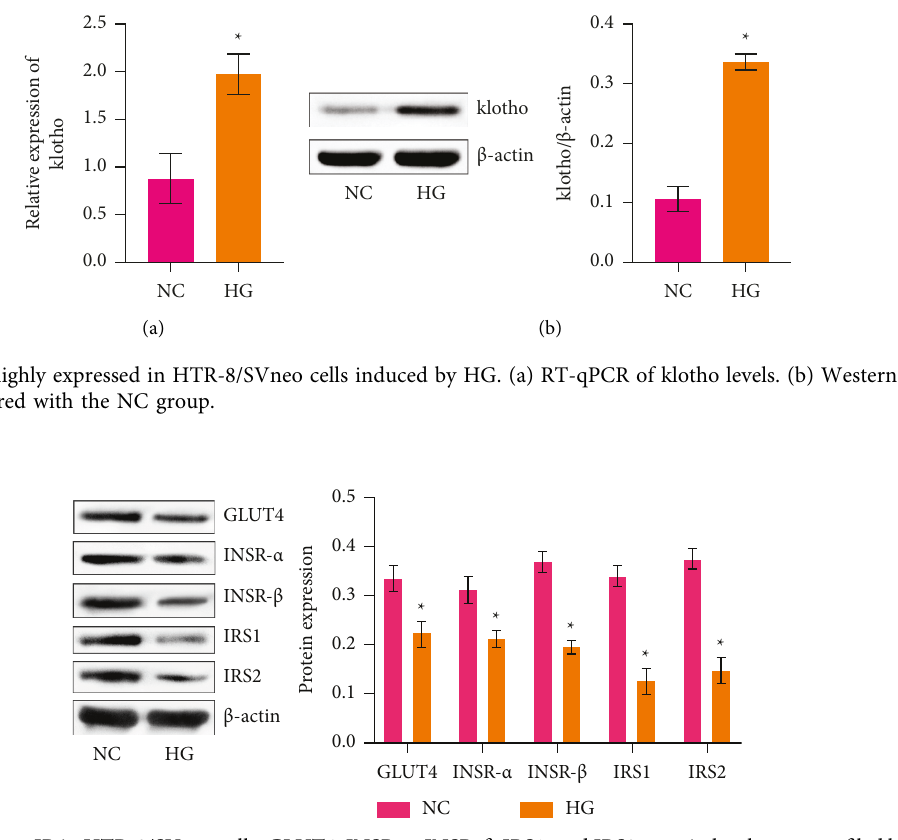
Figure 2: HG could induce IR in HTR-8/SVneo cells. GLUT4, INSR- α , INSR- β , IRS1, and IRS2 protein levels were profiled by western blot. ∗ p < 0 . 05 compared with the NC